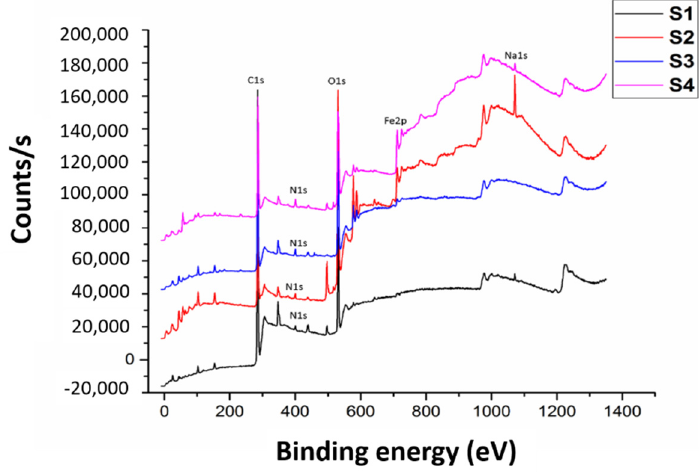
Figure 4. XPS analysis of sintered samples at different dwell times.